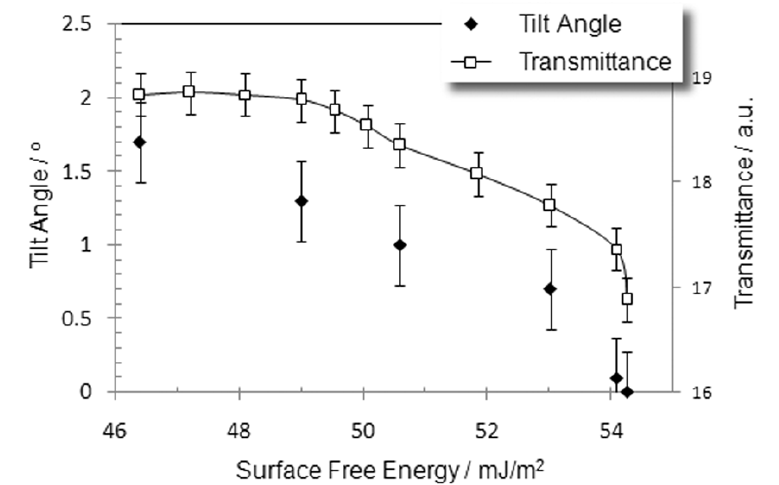
Figure 8. Effect of surface free energy of the substrate on molecular orientation and light transmittance of the DLC